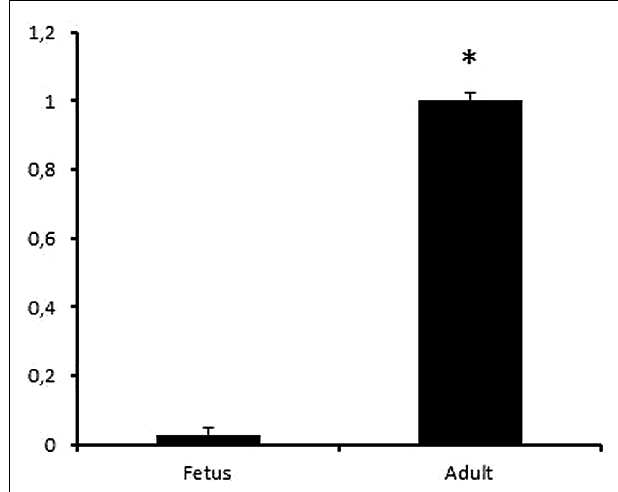
FIGURE 4 | Relative activity of 2-OH-ibuprofen in fetal and adult liver samples. Human liver microsomes obtained from pooled adult ( n = 3) and fetal ( n = 3) livers were incubated with ibuprofen.The analyses were performed in triplicates.The formation of 2-OH-ibuprofen was significantly higher in adult compared to fetal samples, ( p = 0.03). * p < 0.05.